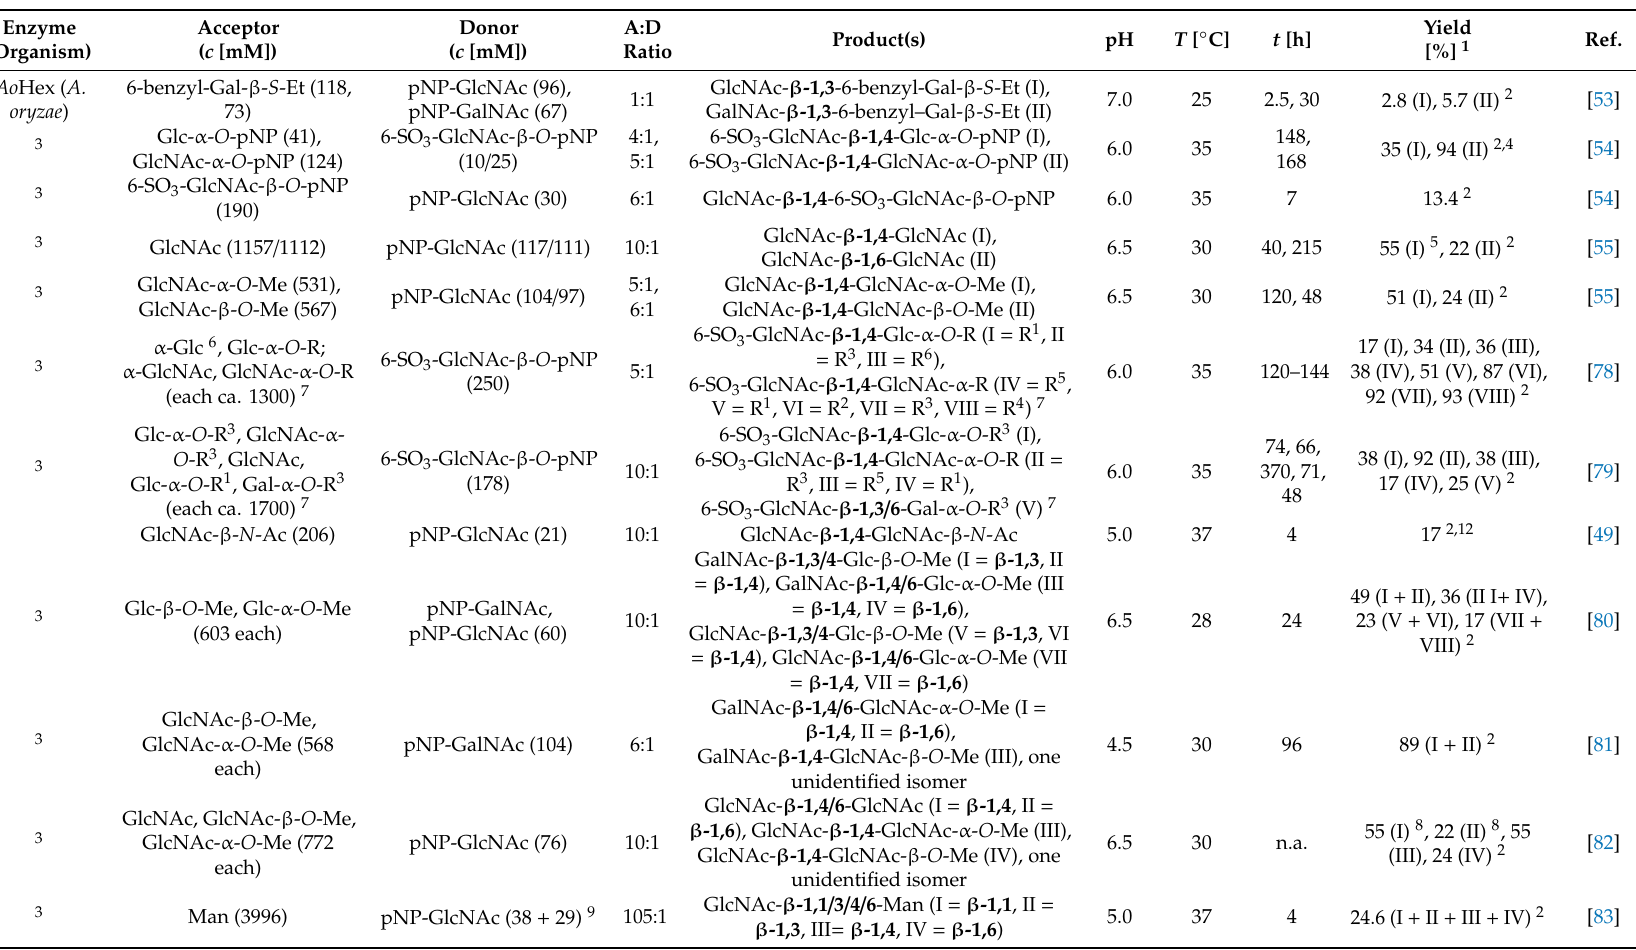
Table 3. Trans-glycosylation reactions catalyzed by GH20 β - N -acetylhexosaminidases from Aspergillus oryzae using pNP-activated carbohydrate donor substrates. New bonds are highlighted in